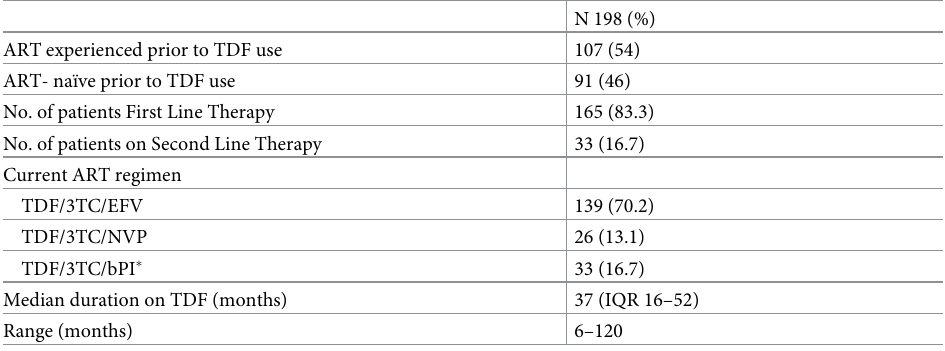
Table 2. ARV exposure of HIV infected children, on TDF for at least 6 months, < 18 years old, (n =